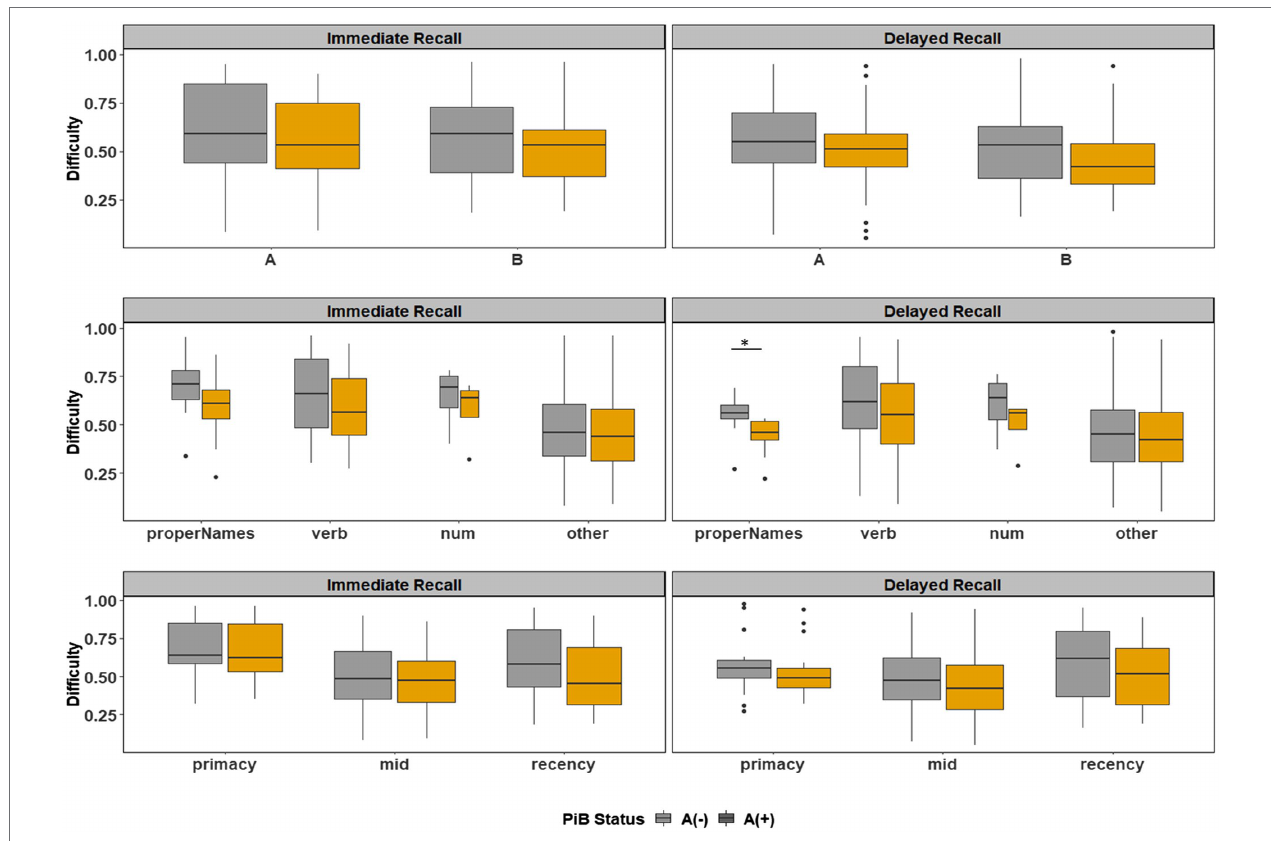
FIGURE 7 | Item difficulty plots by amyloid status according to the story (A and B), serial position (primacy, mid, and recency) as well as the lexical category of the items, by immediate recall and delayed recall. *< 0.05, **< 0.01, ***<0.001, and ****<0.0001.